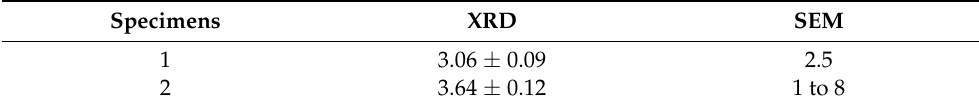
Table 9. Grain size of zeolite crystals using XRD and SEM techniques (in µ